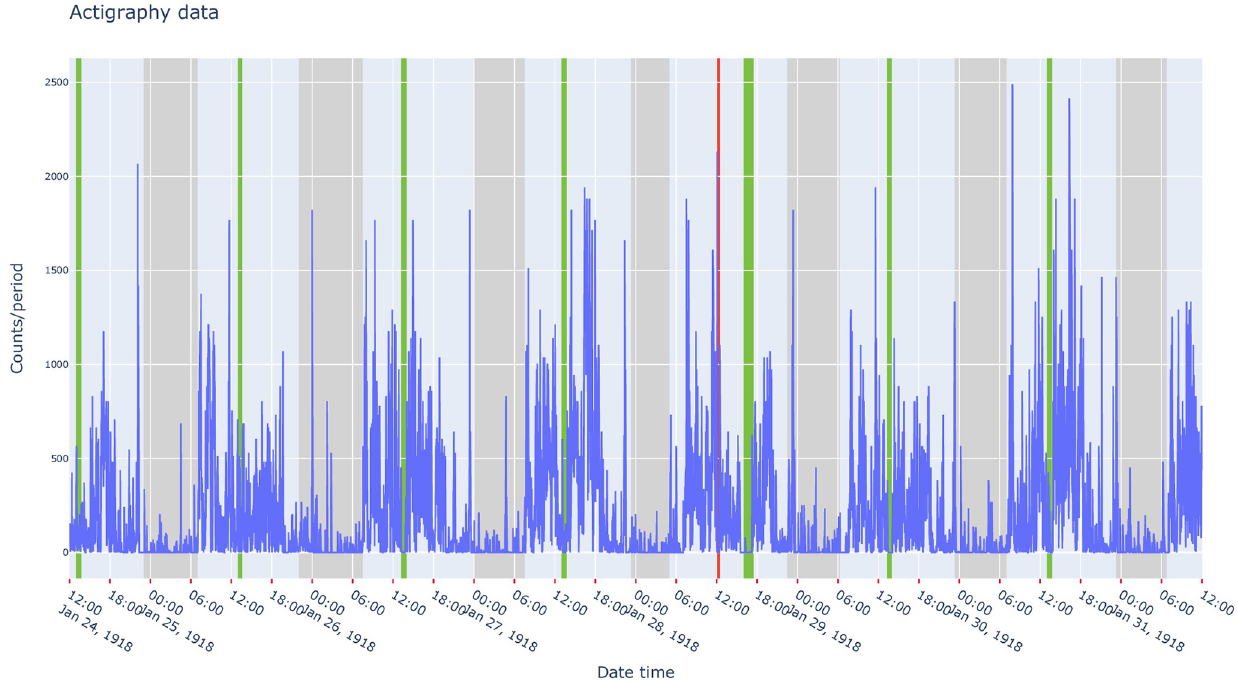
Fig 3. Visualization example of actigraphy data, overlaid with periods (green: Nap, grey: Night, red: Device not worn) reported in the sleep diary example file included in the package.